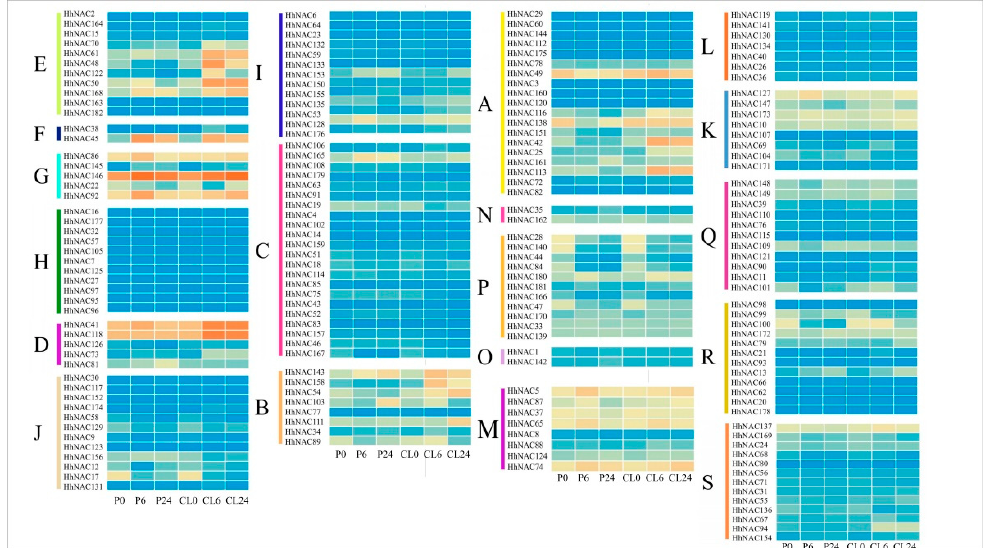
Figure 5. Heat maps of the expression profiles of all HhNAC genes under drought and salt stress (A-S indicated 19 subfamilies). The expression abundance (in log10-based FPKM) of each transcript is represented by the color: orange, higher expression; blue, lower expression. P0 and CL0 = 0 h of drought and salt stress, P6 and CL6 = 6 h of drought and salt stress, and P24 and CL24 = 24 h of drought and salt stress.